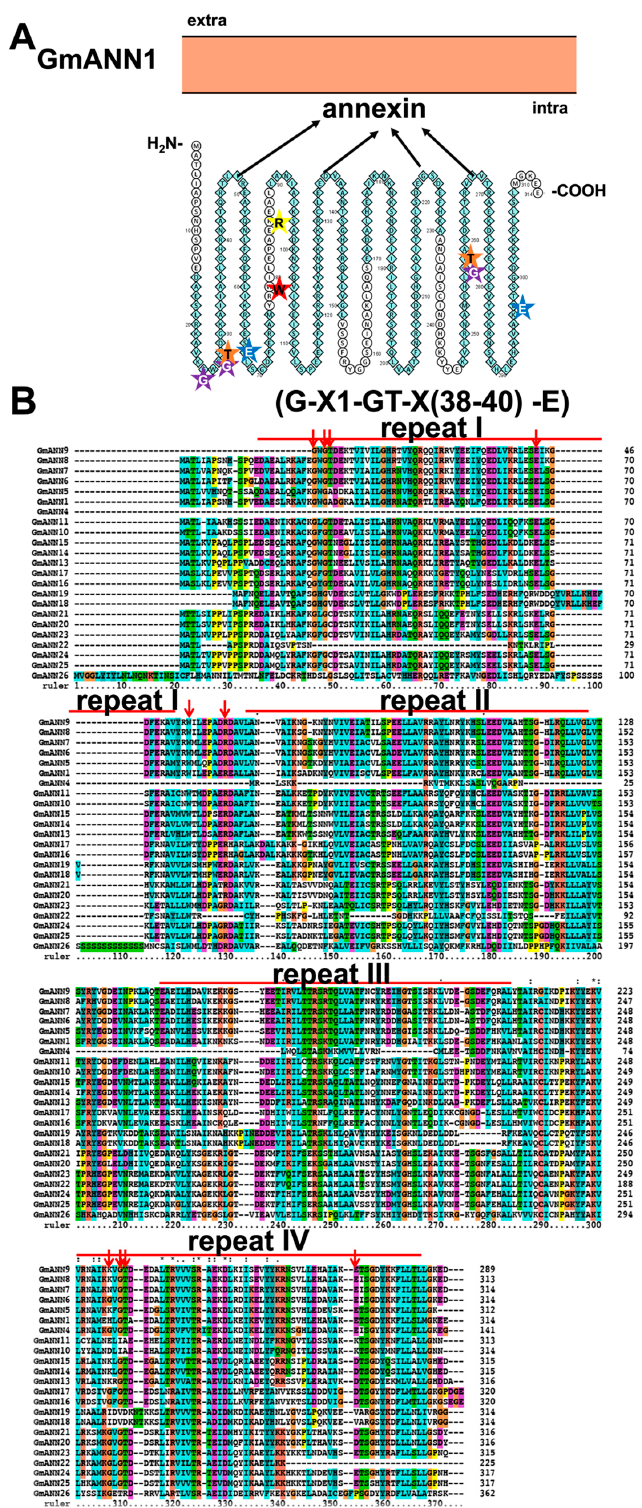
Figure 9. Topology model ( A ) and homology analysis ( B ) of soybean annexins antiporter (ANNs). The red arrows indicate key residues of GmANNs. The conserved residues Ala (G), Thr (T), and Glu (E) in repeats I and IV are indicated by purple, orange, and blue star, respectively. The red star indicates the conserved Trp (W), and the yellow star indicates the conserved Arg (R). The protein topology figure was constructed by using Protter [25]. The protein sequences were aligned by using ClustalX1.83 (http://www.clustal.org/download/, accessed on 17 October